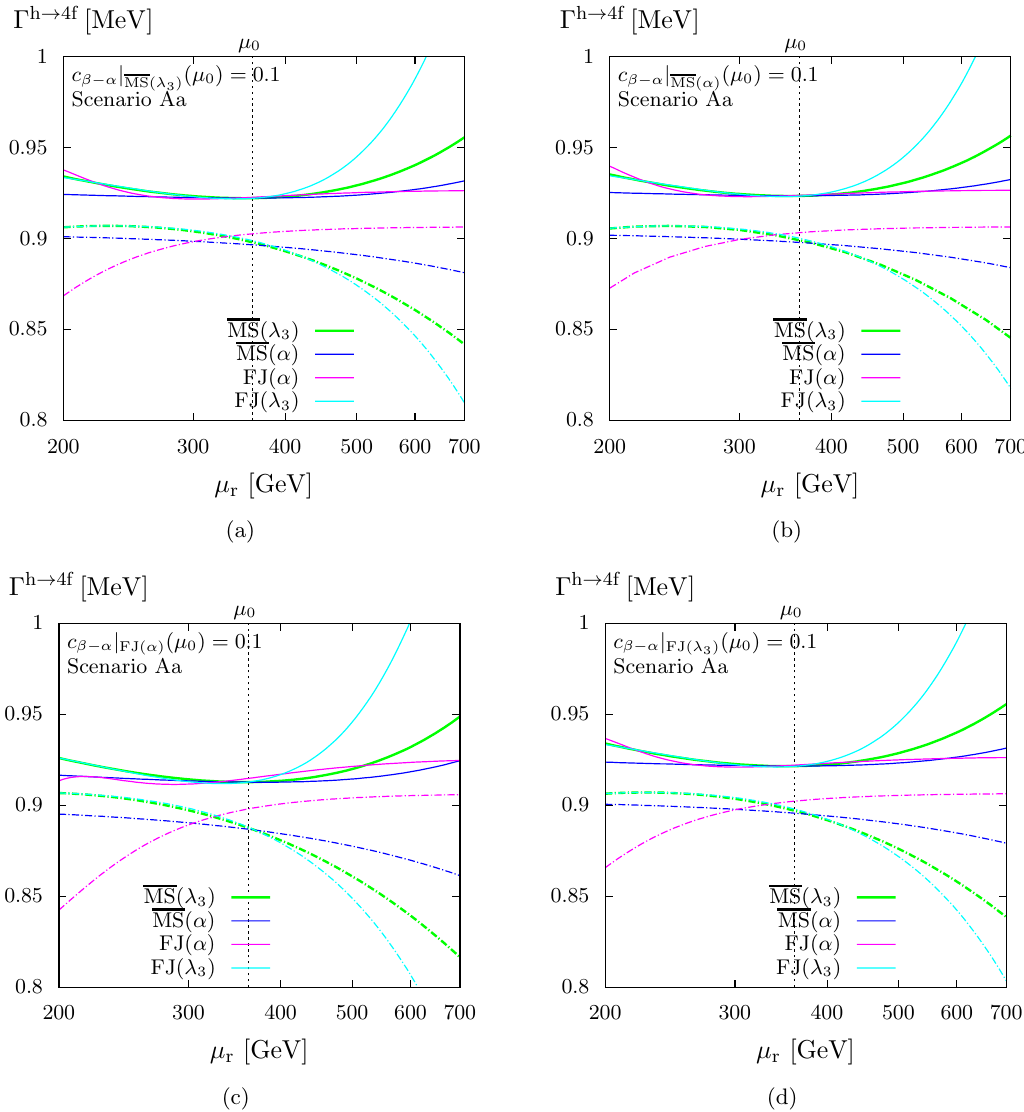
Figure 10 . The h 4 f width at LO (dashed) and NLO EW (solid) for scenario Aa in dependence ! of the renormalization scale. The panels (a), (b), (c), and (d) correspond to input values de(cid:12)ned in the MS( (cid:21) 3 ), MS( (cid:11) ), FJ( (cid:11) ), and FJ( (cid:21) 3 ) schemes, respectively. The result is computed in all four di(cid:11)erent renormalization schemes after converting the input at NLO (also for the LO curves) and displayed using the colour code of (cid:12)gure 9. The dashed vertical line indicates the central renormalization scale (cid:22) r = (cid:22) 0